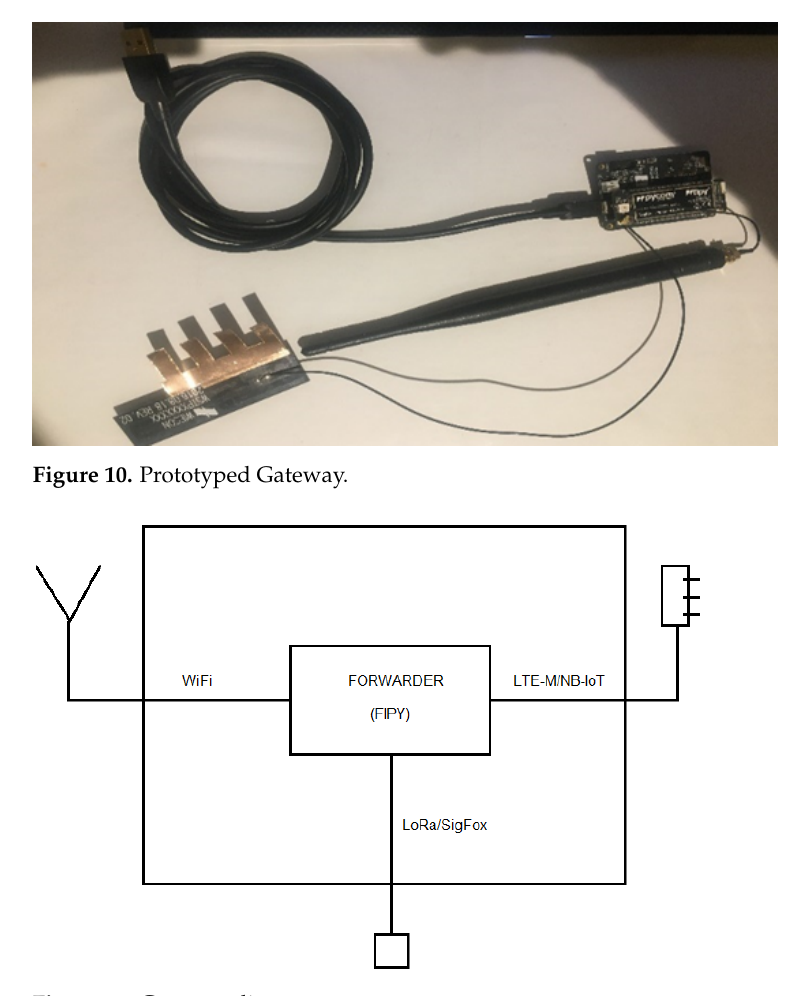
Figure 11. Gateway